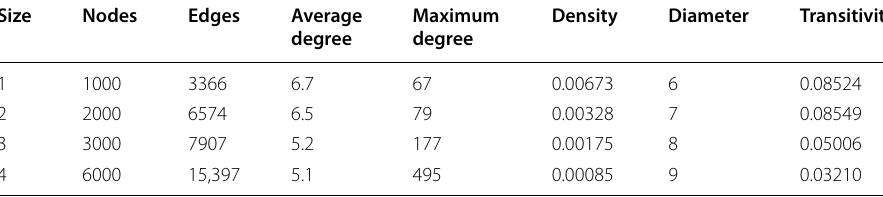
Table 8 Weighted undirected artificial networks generated from the LFR